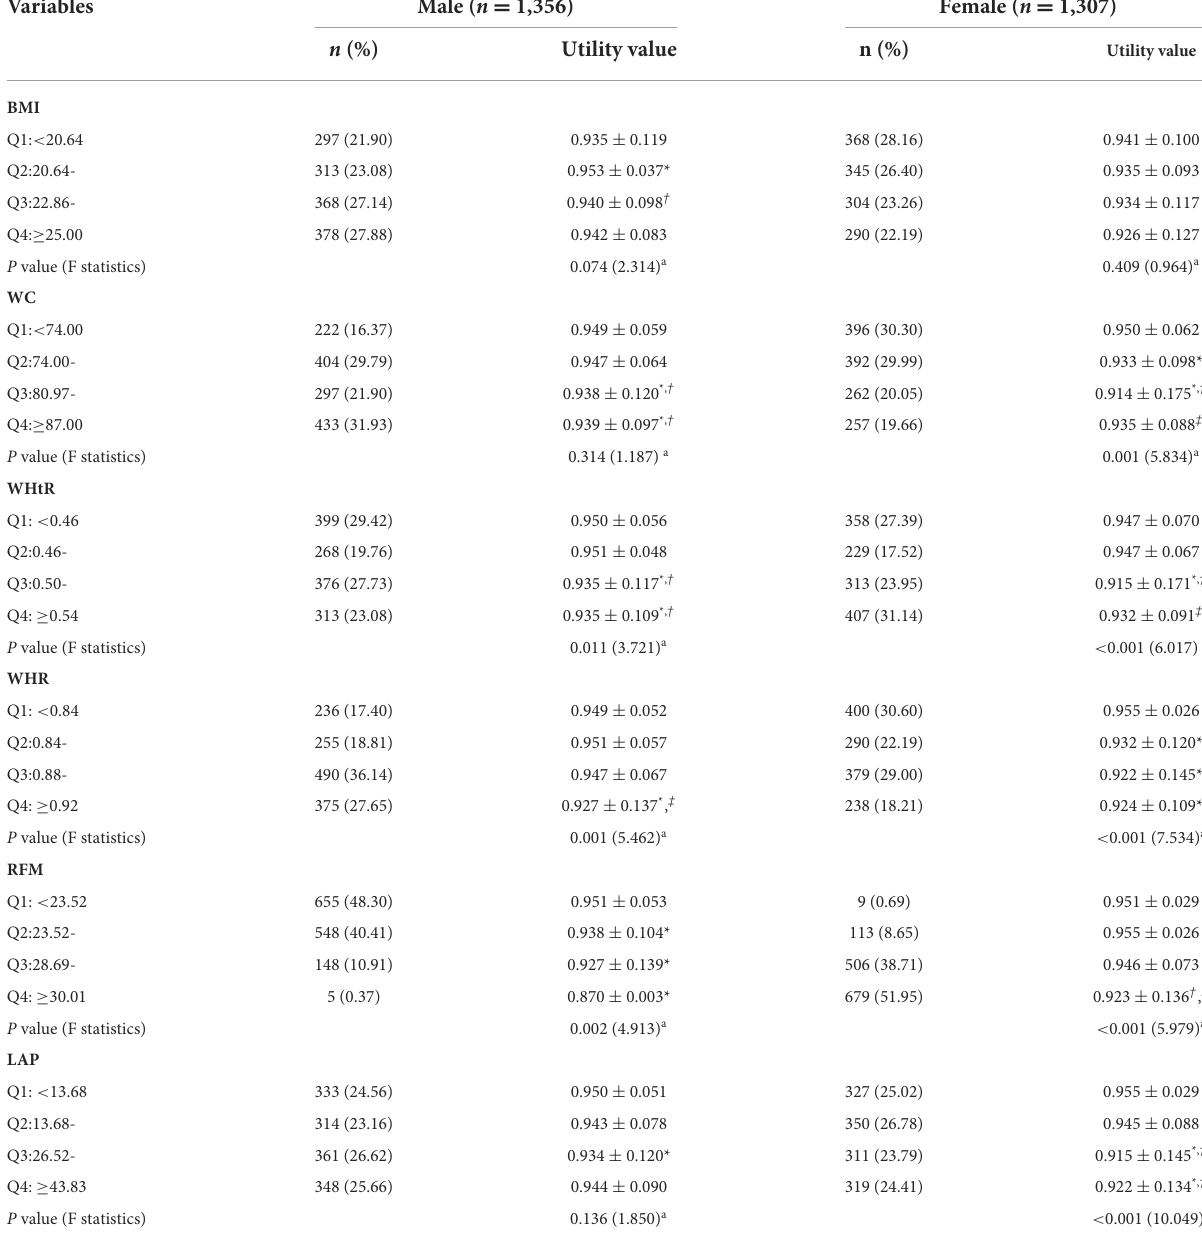
TABLE 2 Comparison of HRQoL of community residents with different levels of anthropometric indicators by gender ( n = 2,663). Variables Male ( n =